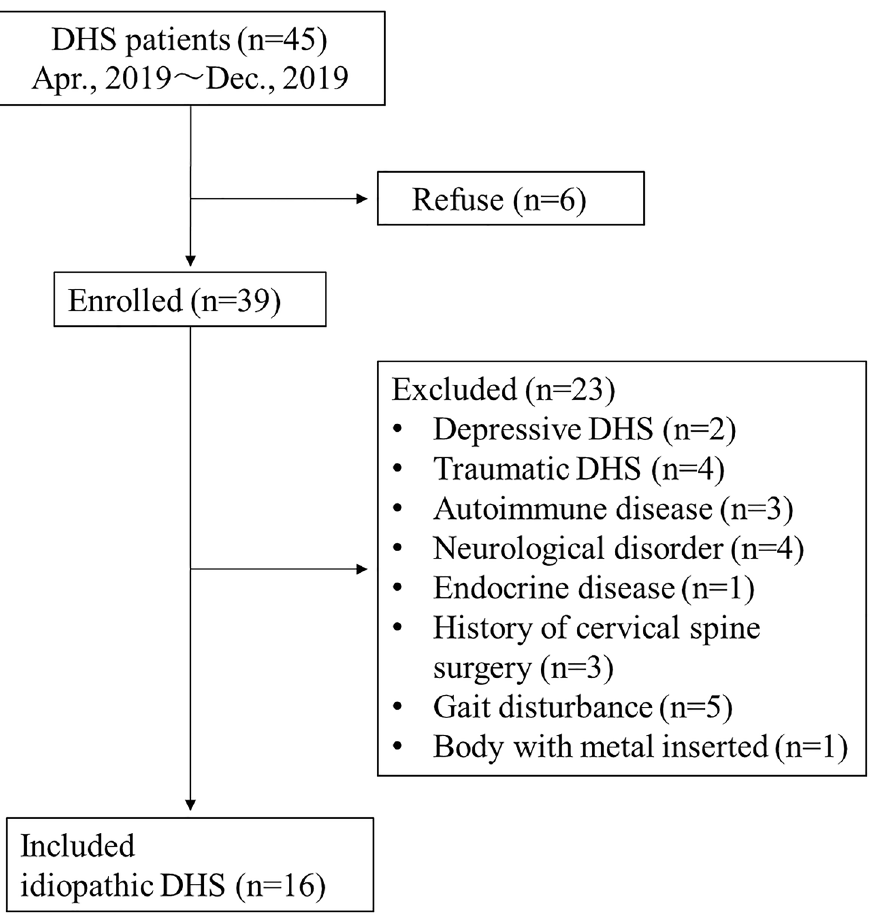
Figure 1. Flowchart of patient enrollment. DHS dropped head